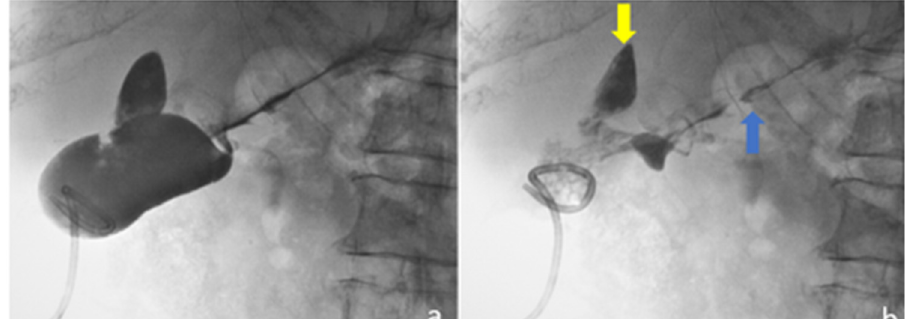
Figure 7. Ultrasound-guided percutaneous cholecystostomy with pigtail catheter inside gallbladder. ( a ) Gallbladder opacification through drainage catheter with occluded cystic duct; ( b ) after aspiration of the contrast medium, multiple small stones are seen in the gallbladder and contrast stain is also seen outside the gallbladder towards the liver parenchyma (yellow arrow) and the lower liver capsule (blue arrow).